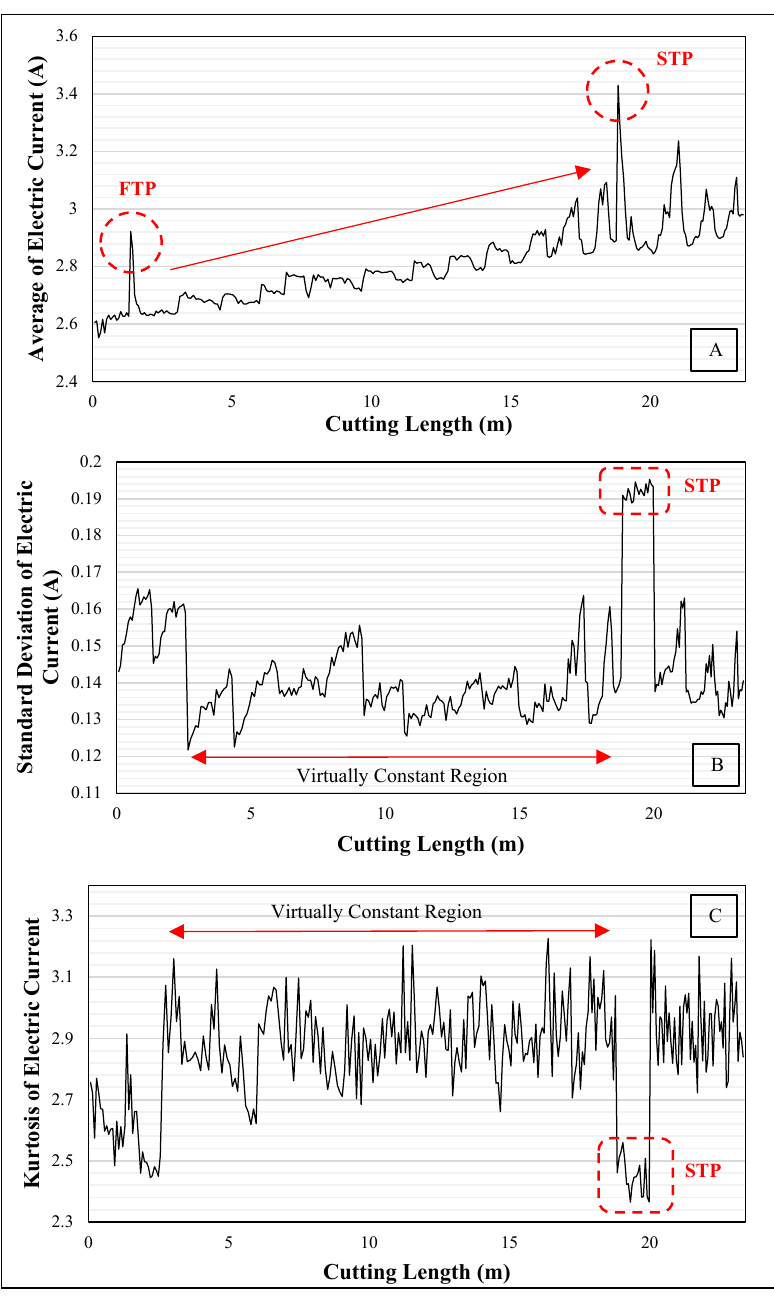
Figure 8. The conventional statistical analysis of the spindle electric current signal. ( A ) The average of the spindle electric current signal as a function of the cutting length ( B ) The standard deviation of the electric current signal as a function of the cutting length ( C ) The kurtosis of the electric current signal as a function of the cutting length.